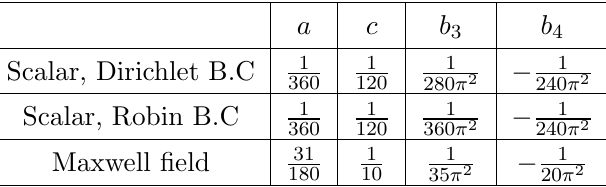
Table 2 . Central charges for 4d free